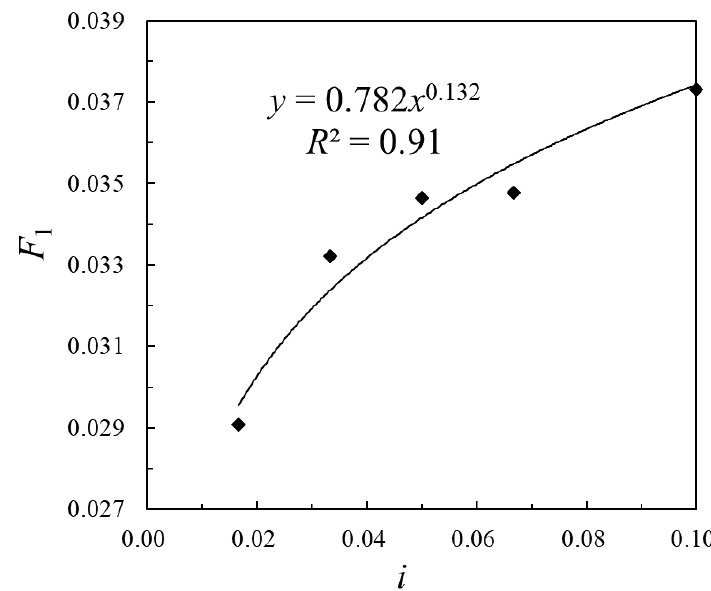
Figure 12. Relationship between the gradient i and F 1.